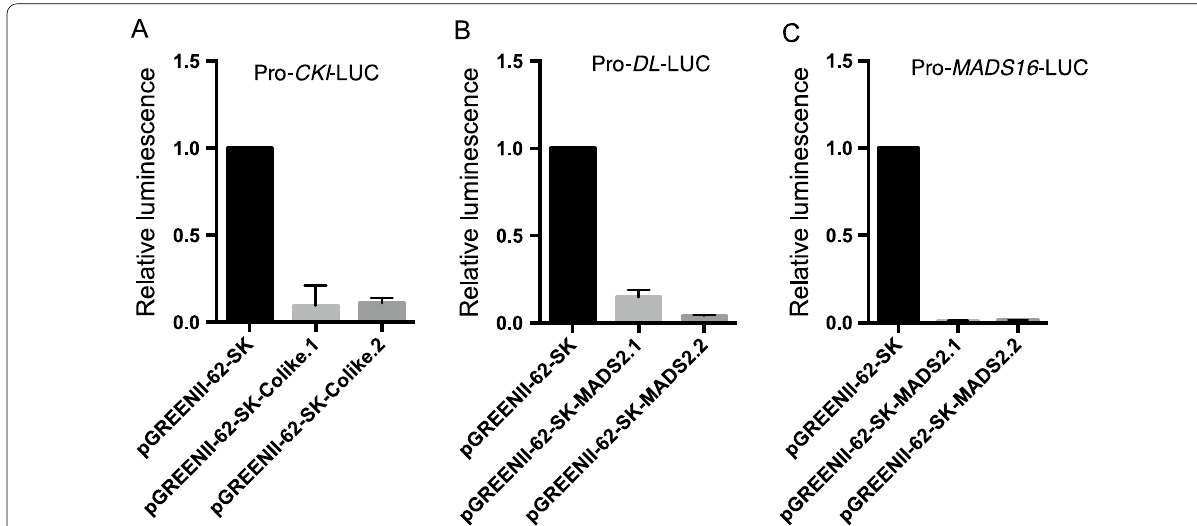
Fig. 7 Validation the transcriptional inhibition role of alternative spliced transcription factors. a Coexpression of Colike and Colike.2 with LUC driven by the CKI promoter in protoplasts. Empty vector of pGREENII 0800-LUC mixed with the relative isoform was used as negative control. b Coexpression of MADS2 and MADS2.2 with LUC driven by the DL promoter in protoplasts. Empty vector of pGREENII 0800-LUC mixed with the relative isoform was used as negative control. c Coexpression of MADS2 and MADS2.2 with LUC driven by the MADS16 promoter in protoplasts. Empty vector of pGREENII-62-SK mixed with the relative promoter of the targets were used as control. Bar graphs show means with two biological replications. Error bars show SD. The relative luminescence of control was set as ±